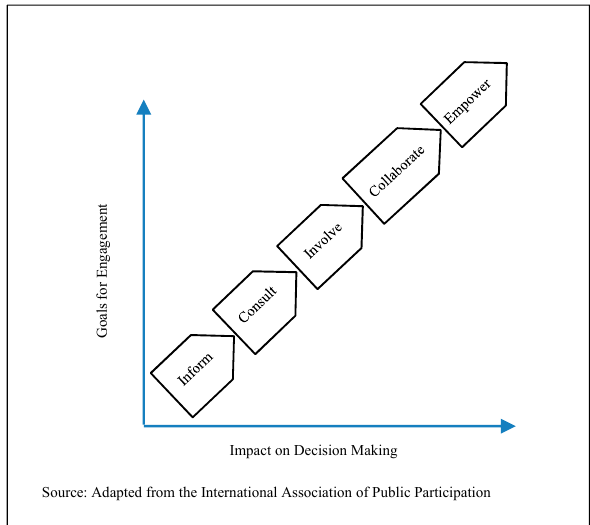
Figure 1. IAP2 Spectrum.